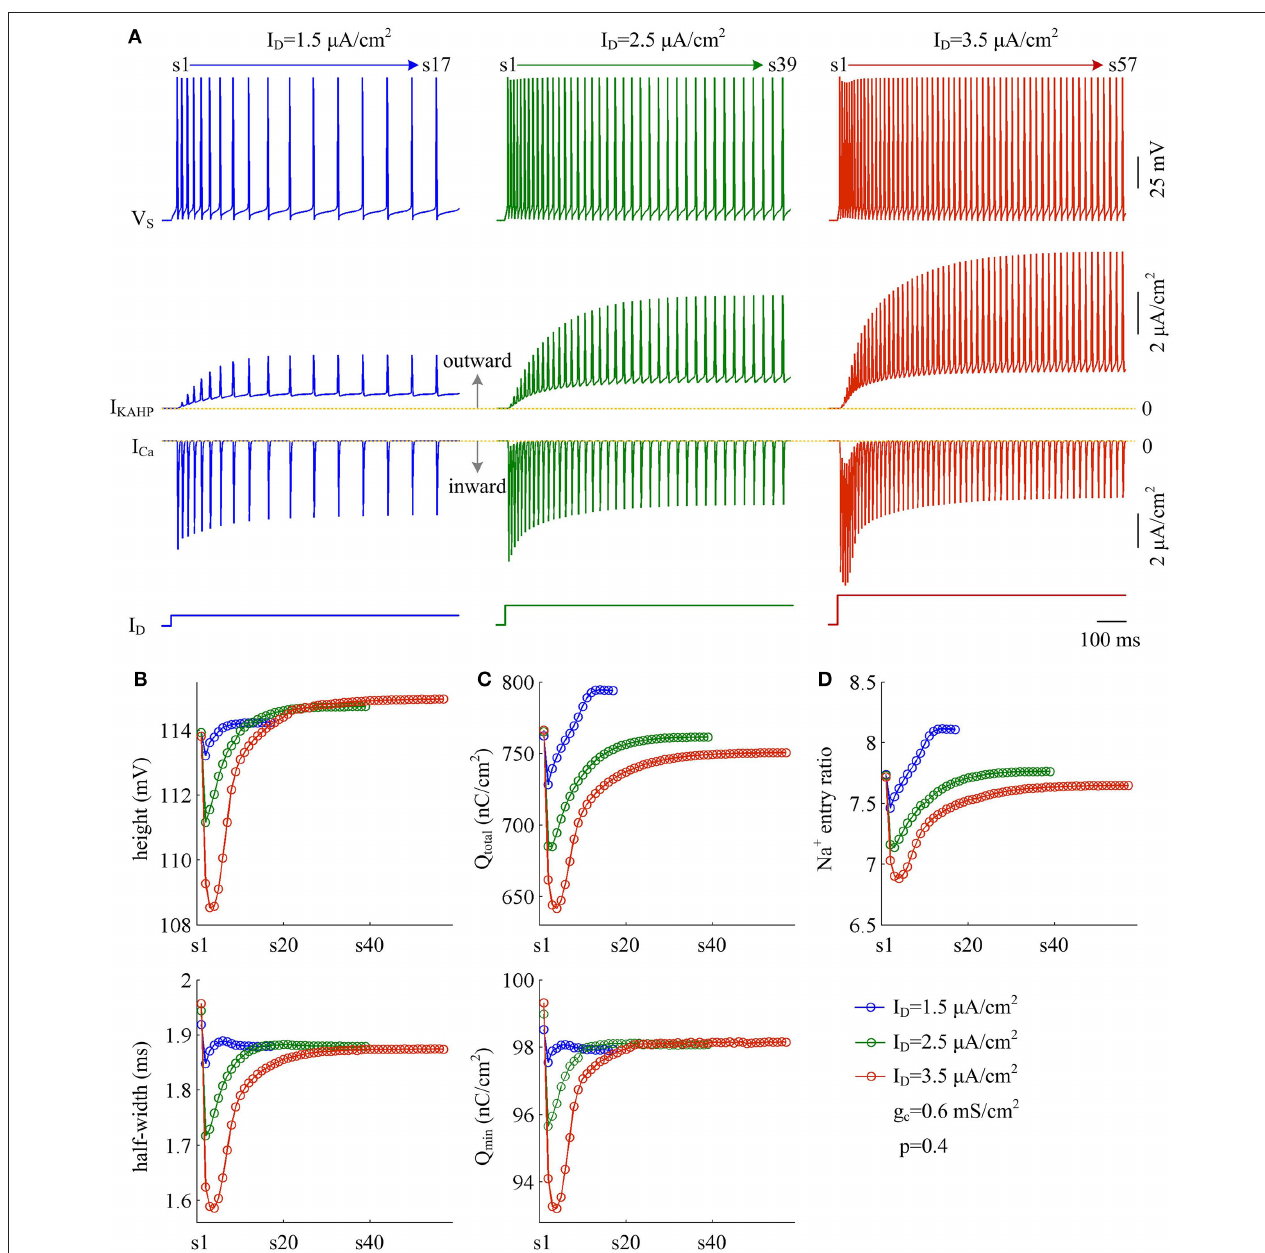
FIGURE 12 | Activation of I KAHP by strong dendritic input results in inefficient APs. (A) Sample responses of the model III neuron evoked by I D = 1.5 µ A / cm 2 , 2.5 µ A / cm 2 , and 3.5 µ A / cm 2 . V S , I KAHP , and I Ca are plotted against time. During the interval of 1000 ms, model III neuron respectively generates 17, 39, and 57 APs. (B) The height (top) and half-width (bottom) of each AP with three values of I D . (C) Total Na + load Q total (top) and minimal Na + load Q min (bottom) of each AP. (D) Excess Na + entry ratio of each AP. Note that three intensities of I D are all below the threshold for activating I Ca to trigger dendritic Ca 2 + spike. Once I D reaches that threshold, the activated I Ca dominates the outputs of model III neuron, and the SFA will disappear. p = 0.4 and g c = 0.6 mS / cm 2